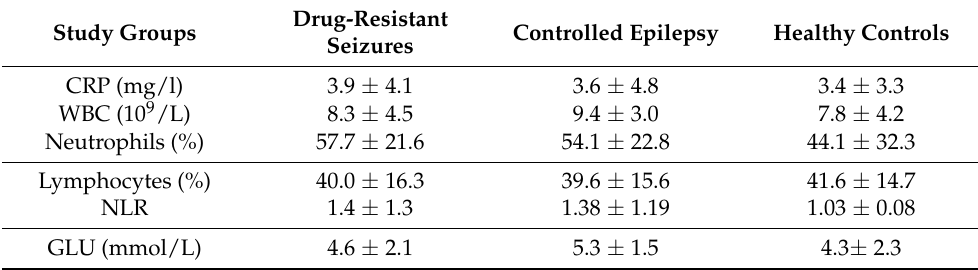
Table 2. Systemic laboratory findings. Presented as means ± SD.